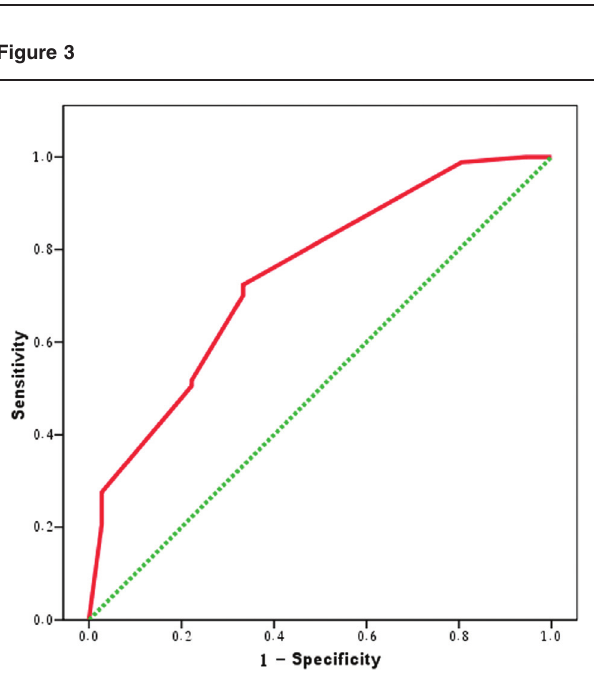
Receiver operating characteristic curve for computed tomography scoring as a predictor for